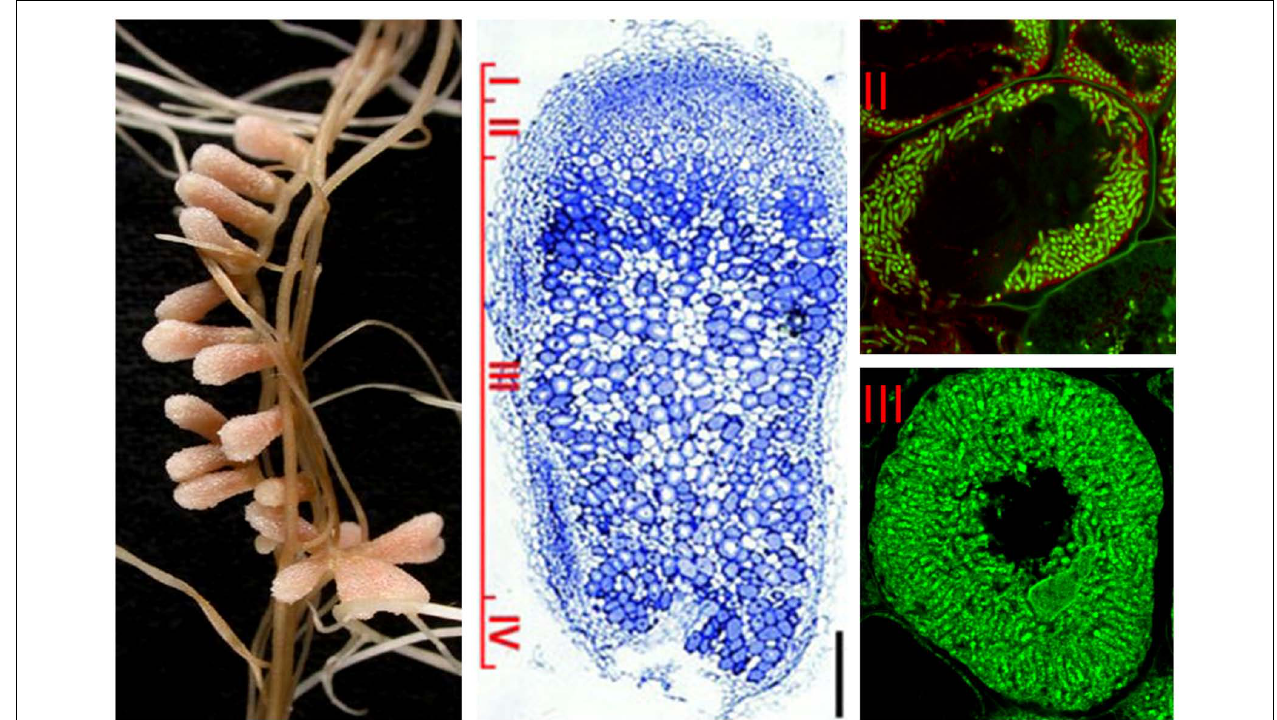
FIGURE 1 | Structure of nitrogen-fixing root nodules formed in S. meliloti – M. truncatula symbiosis. The different nodules zones are indicated on the longitudinal nodule section: (I) meristem, (II) infection zone, (III) nitrogen fixation zone, (IV) senescence zone.